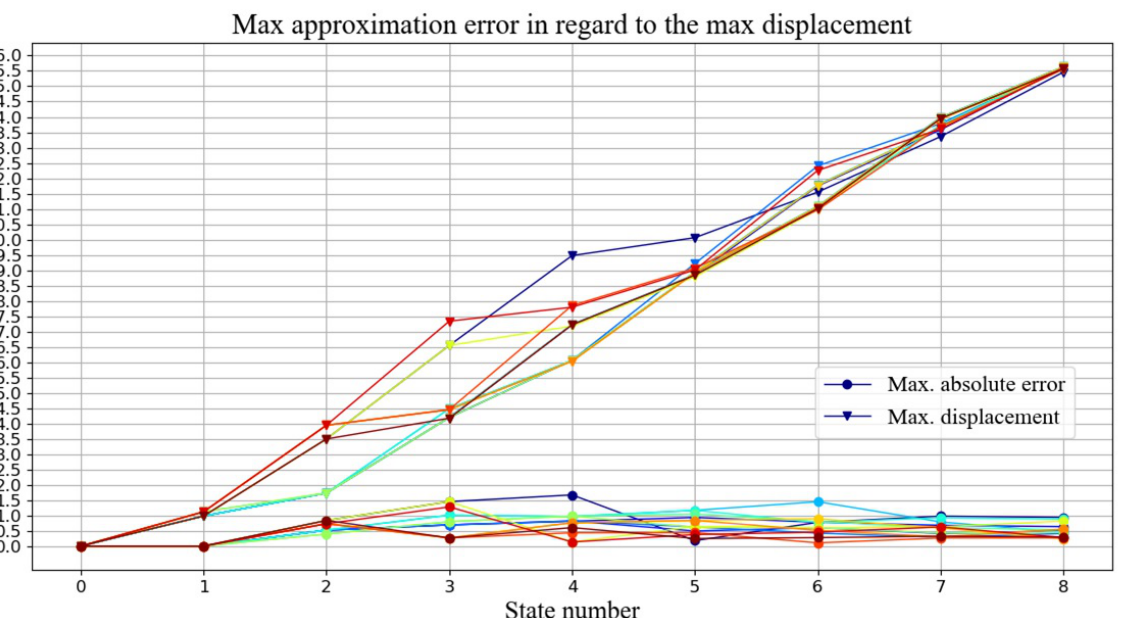
Figure 16. Maximum prediction error and maximum displacement for the DMD approximation without topology clustering.